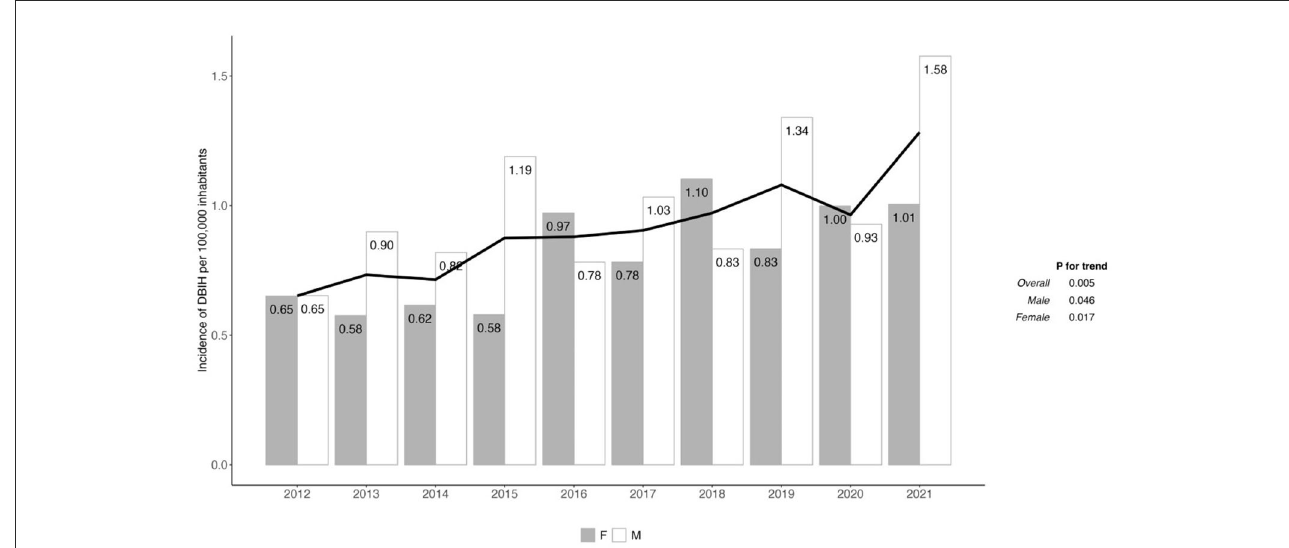
FIGURE1 The trends of dog bite injury hospitalizations (DBIH) from 2012 to 2021 across both sexes. In particular, females showed an increase in the rates of DBIH over the 10 years examined.